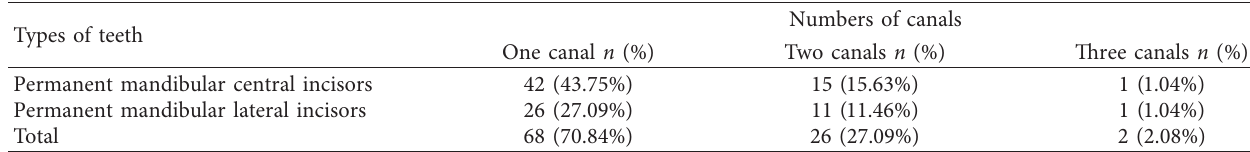
Table 6: Distribution of number (%) of root canal in permanent mandibular central and lateral incisors (summary table). Types of teeth